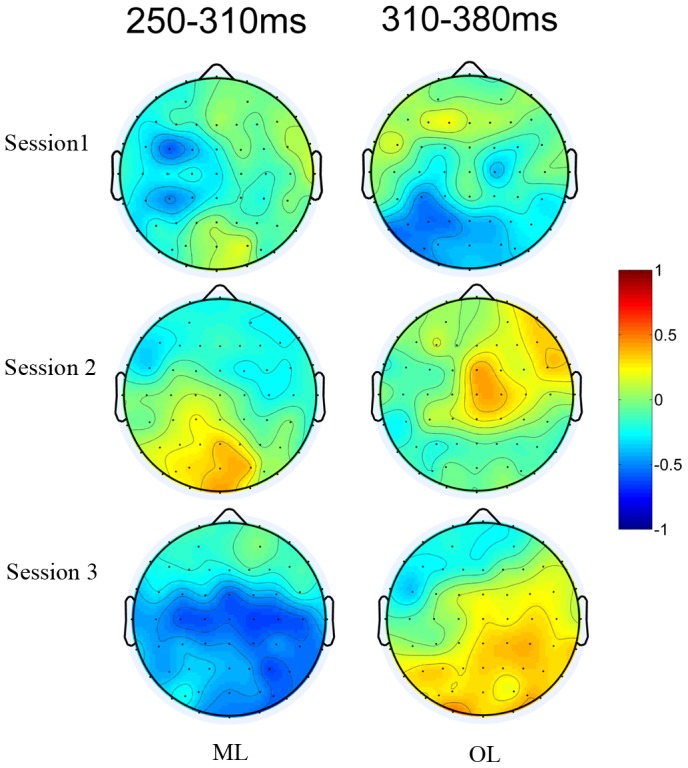
Topography of changes in the distance effect across the three tests administered during the three training sessions.The distance effect (far distance – close distance) over the time windows of 250–310 ms and 310–380 ms for the ML and OL groups.